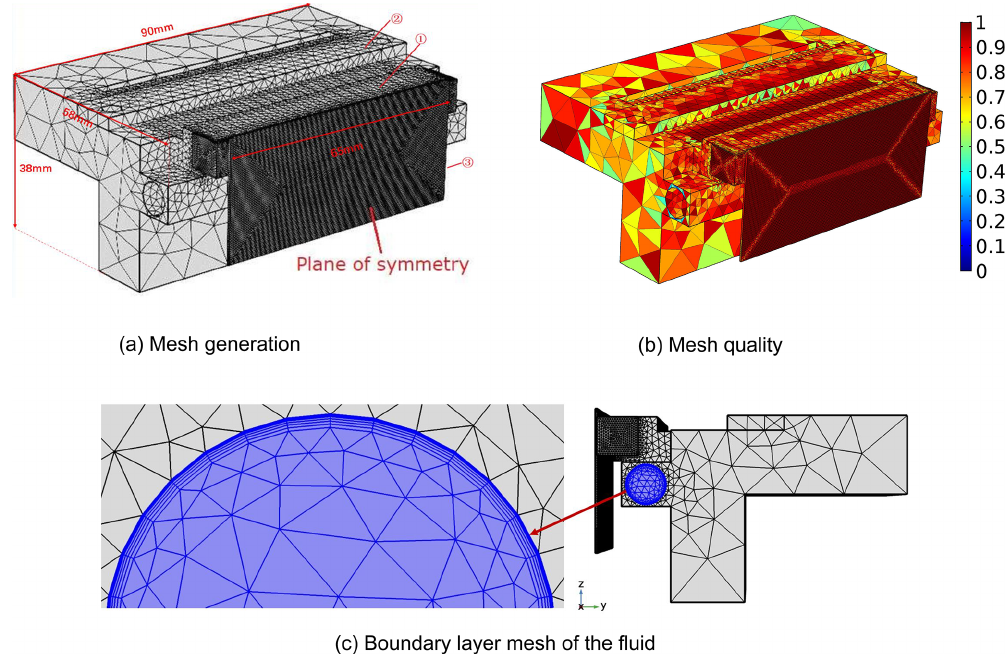
Figure 7. Meshing and mass distribution. (a) Mesh generation. (b) Mesh quality. (c) Boundary layer mesh of the fluid.